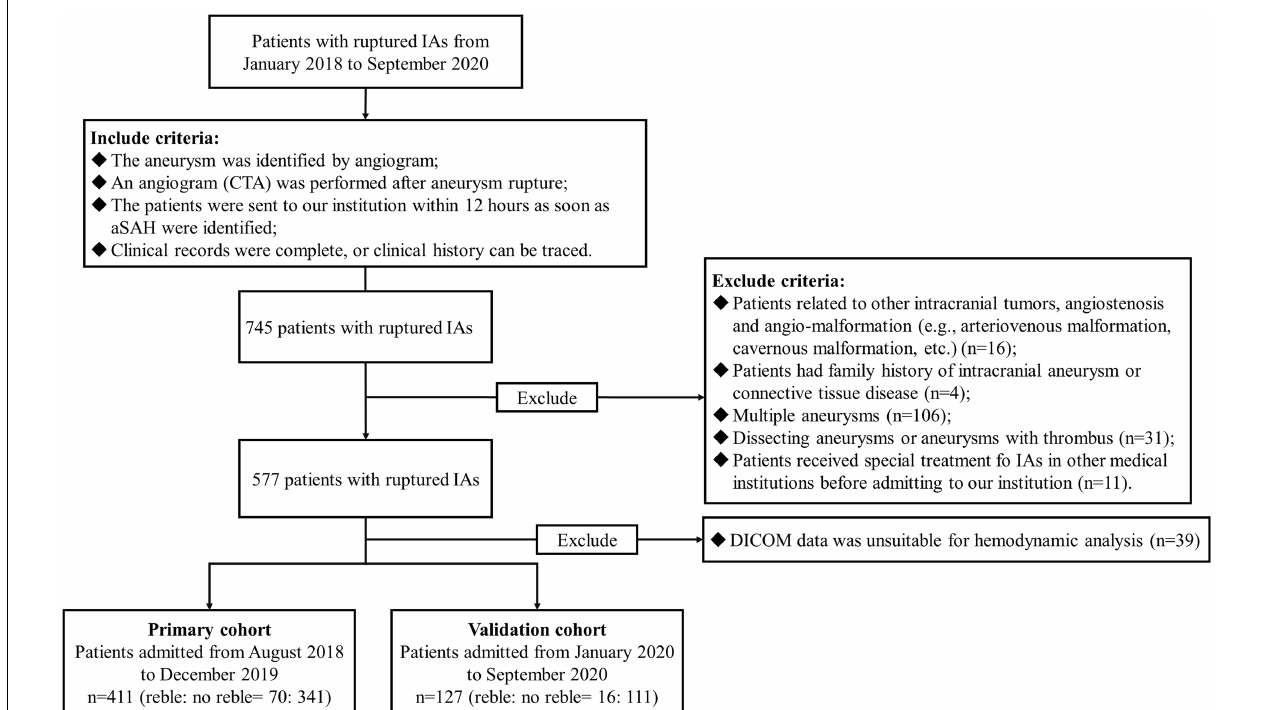
FIGURE 1 | The study flow chart. In this study, 411 appropriate patients with ruptured IAs were reviewed. A total of 70 patients were identified as rebleeding after the admission. Patients enrolled from August 2018 to December 2019 formed the primary cohort (411 patients with 411 IAs), which was adopted to develop the predictive model; while patients enrolled from January 2020 to September 2020 were classified as the validation cohort (127 patients with 127 IAs). IAs, intracranial aneurysms; DICOM, Digital Imaging and Communications in Medicine data.